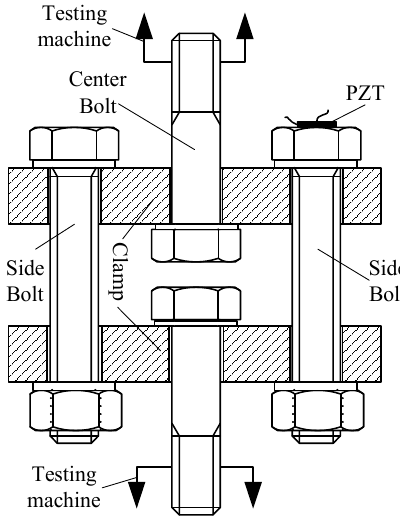
Figure 1. Schematic diagram of the bolt clamp.